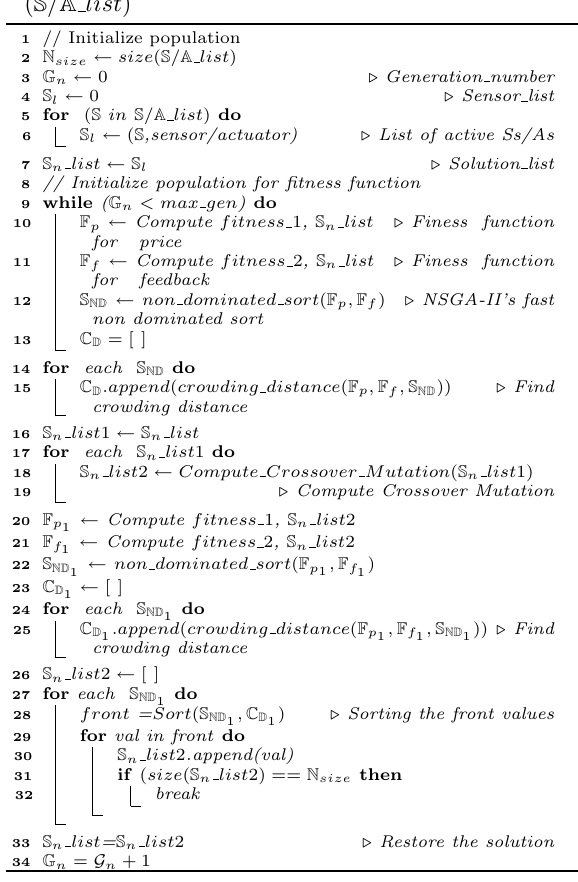
Algorithm 1: NSGA-II based SALFSD -1